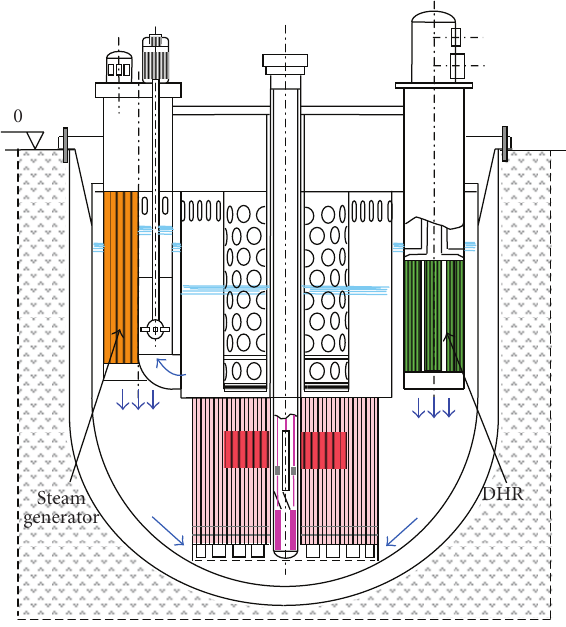
Figure 1: Scheme of the EFIT reactor block.